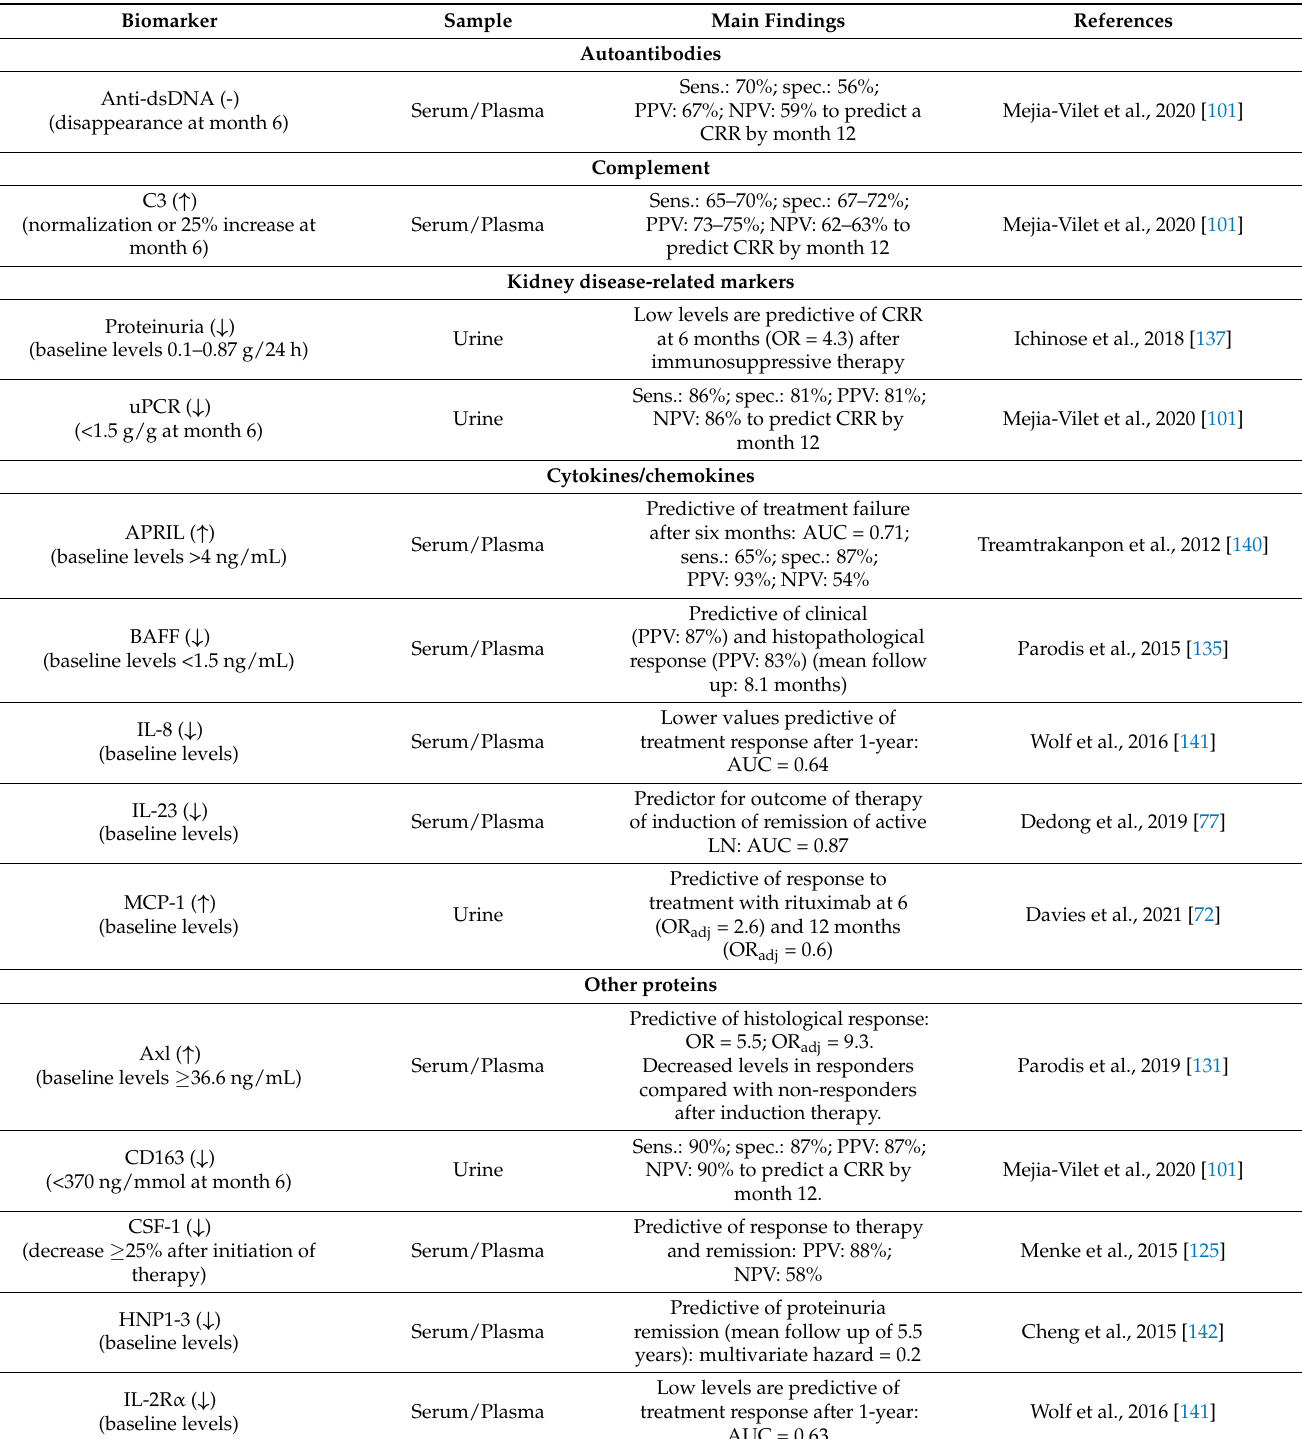
Table 5. Performances of selected biomarkers of responses to therapy in